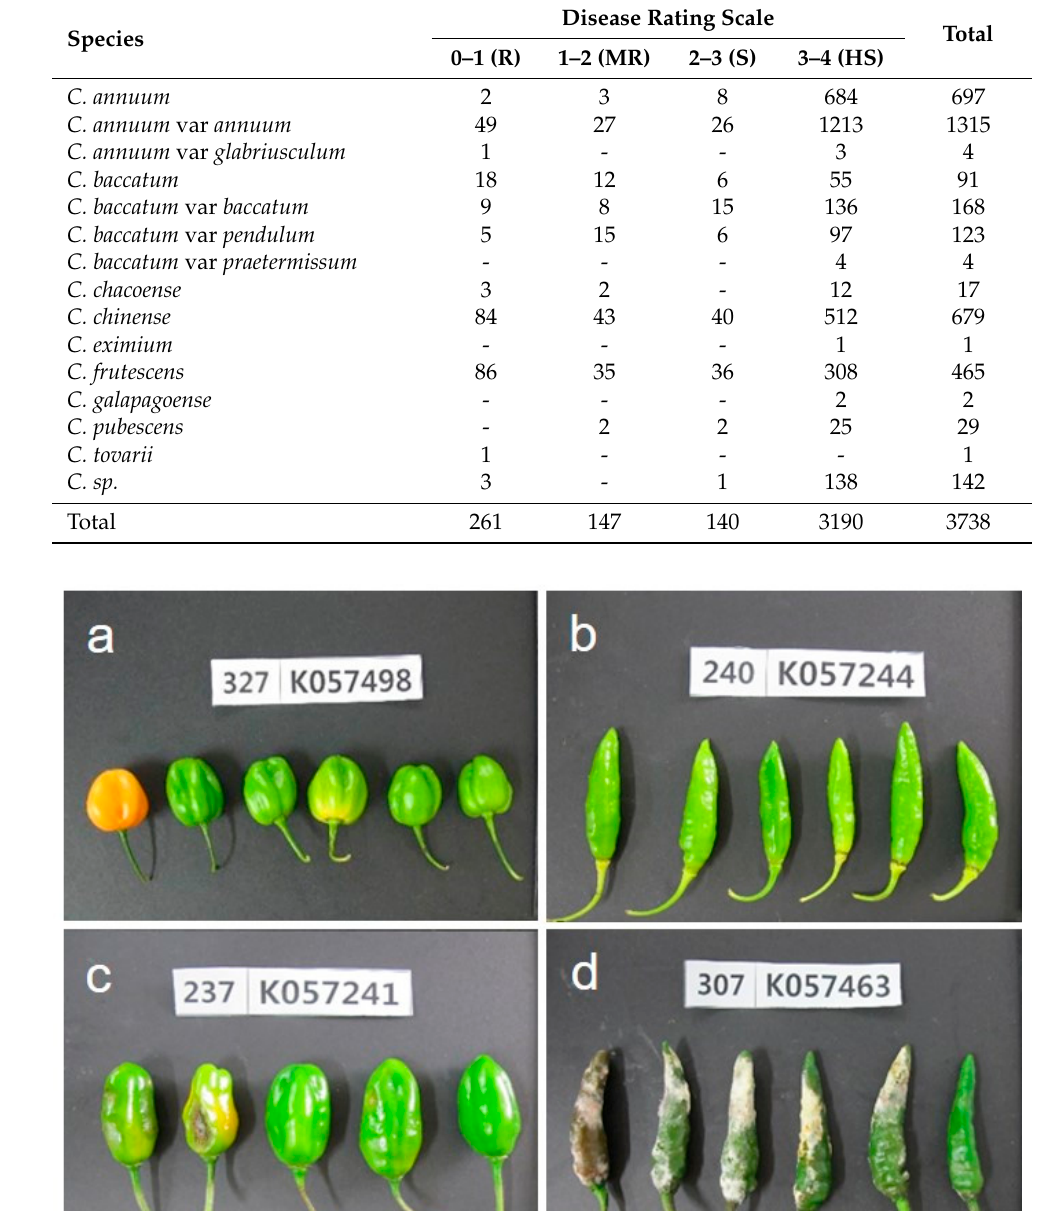
Table 2. Distribution of disease rating scale among the tested pepper germplasm resources against C. acutatum by non-wounding inoculation.